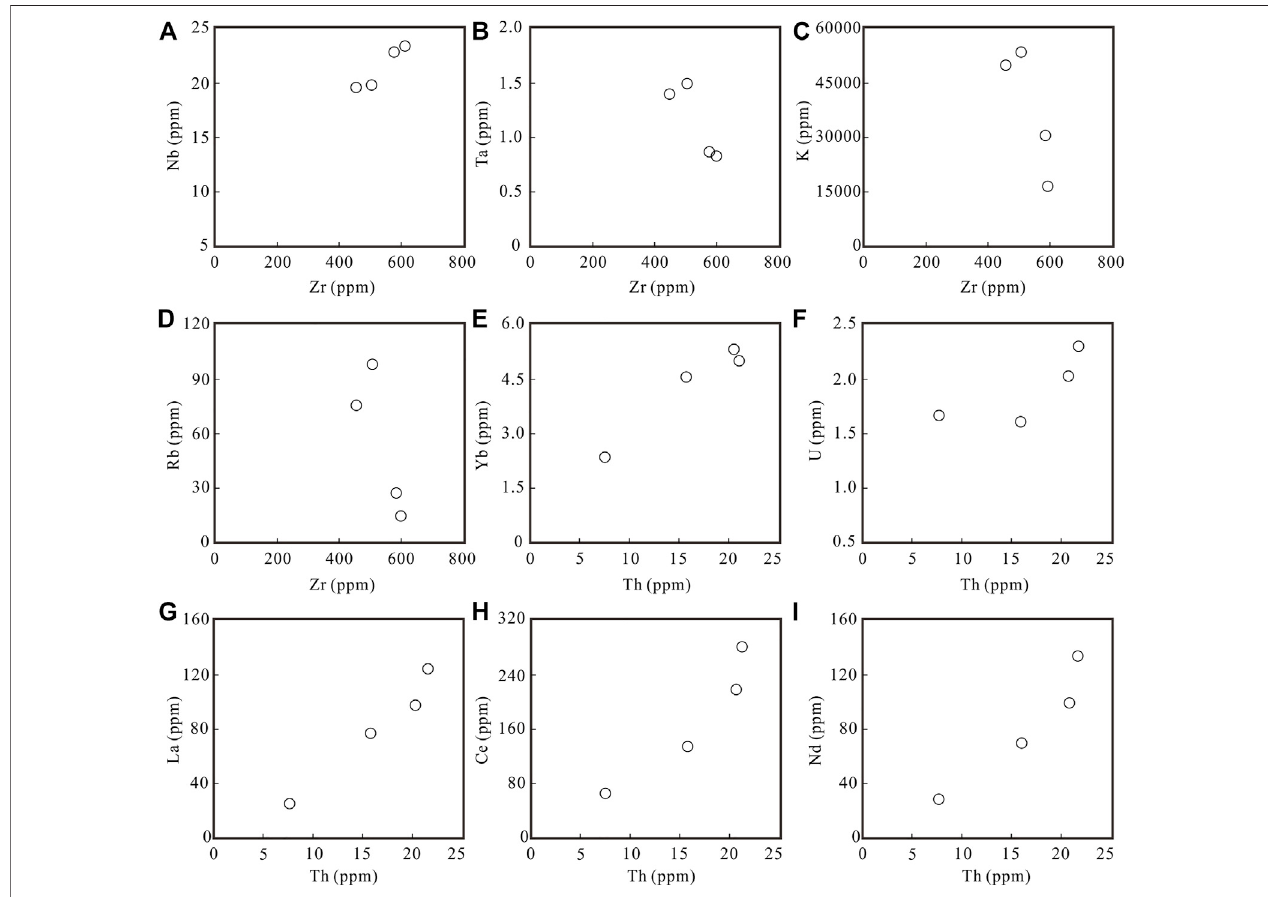
FIGURE7| Diagramsshowingvariationsofselectedelements (A) Nb, (B) Ta, (C) K, (D) Rbvs. Zrand (E) Yb, (F) U, (G) La, (H) Ce, (I) Ndvs. Thinthelamprophyre samples to check for element mobility during post-magmatic alteration.